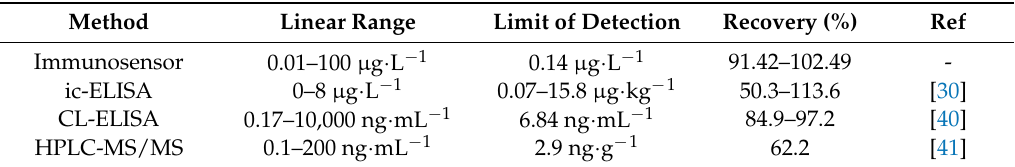
Table 1. Comparison of the sensing characteristics of our immunosensor and the reported ELISA and HPLC-MS/MS